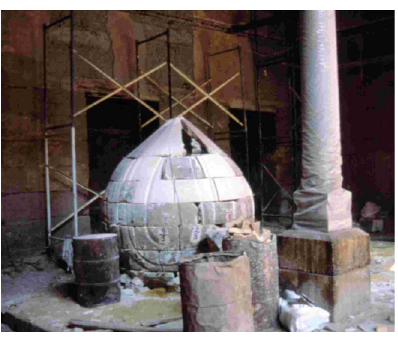
a Damage to the top part of North